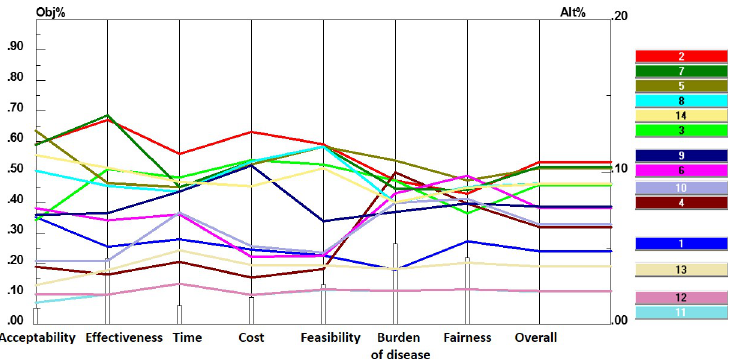
Fig 5. Sensitivity analysis of potential solutions based on the seven criteria (acceptability, effectiveness, time, cost, feasibility, burden of disease, and Fairness) and overall priority.